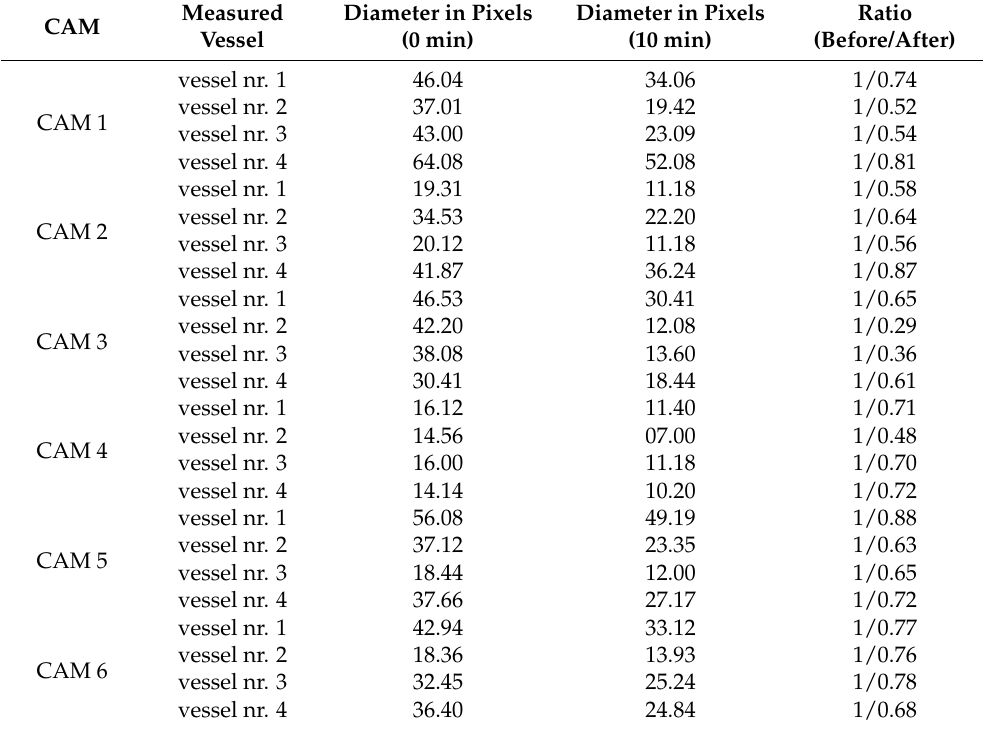
Table 1. Vessel Lumen Assessment.